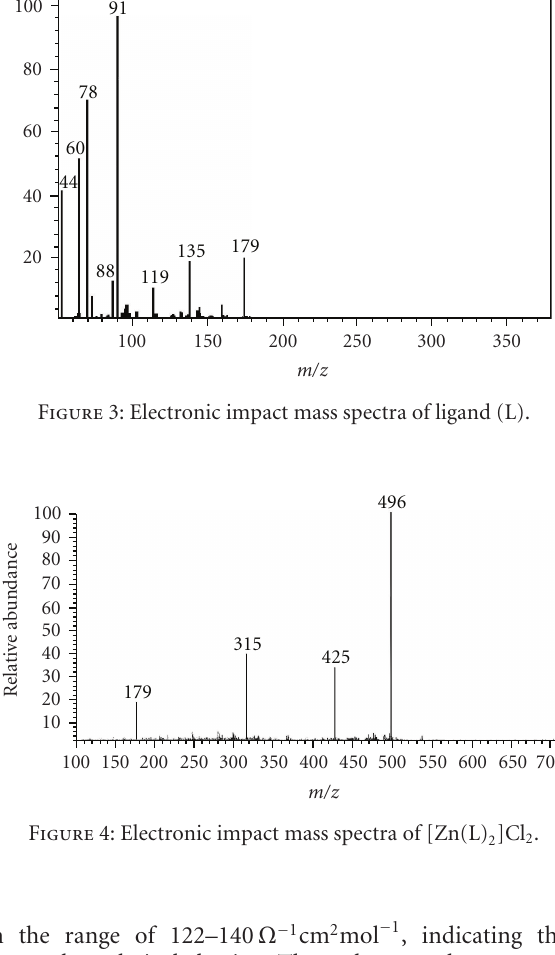
Figure 4: Electronic impact mass spectra of [Zn(L)